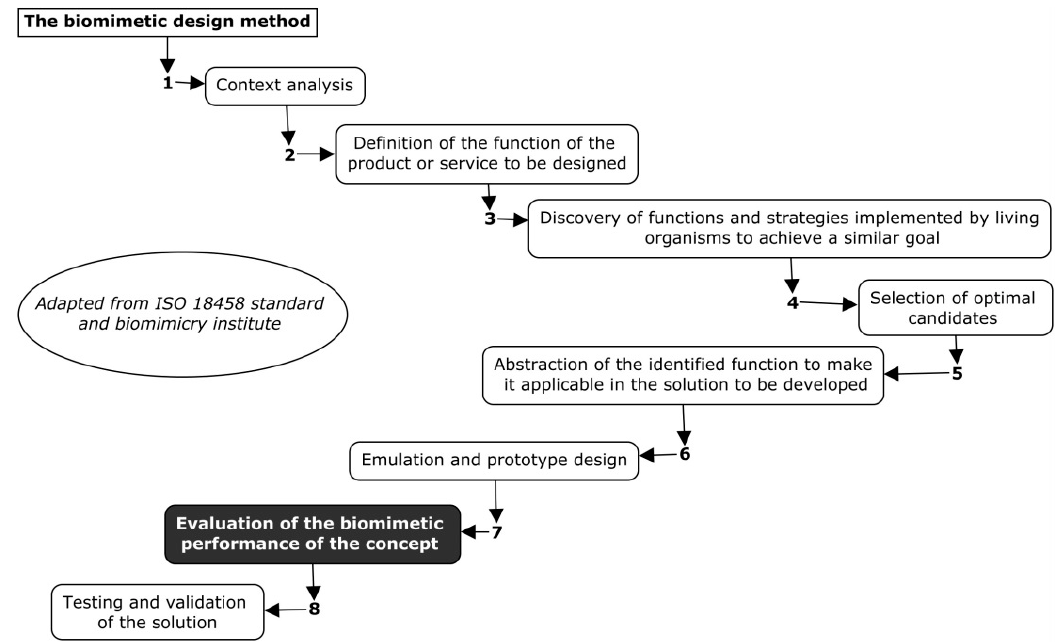
Figure 1. The biomimetic design method. Adapted from [3].